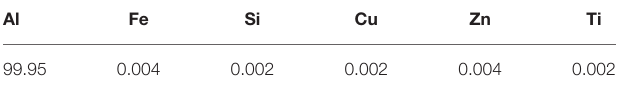
TABLE 1 | Elemental composition of Al sample (mass fraction, %).